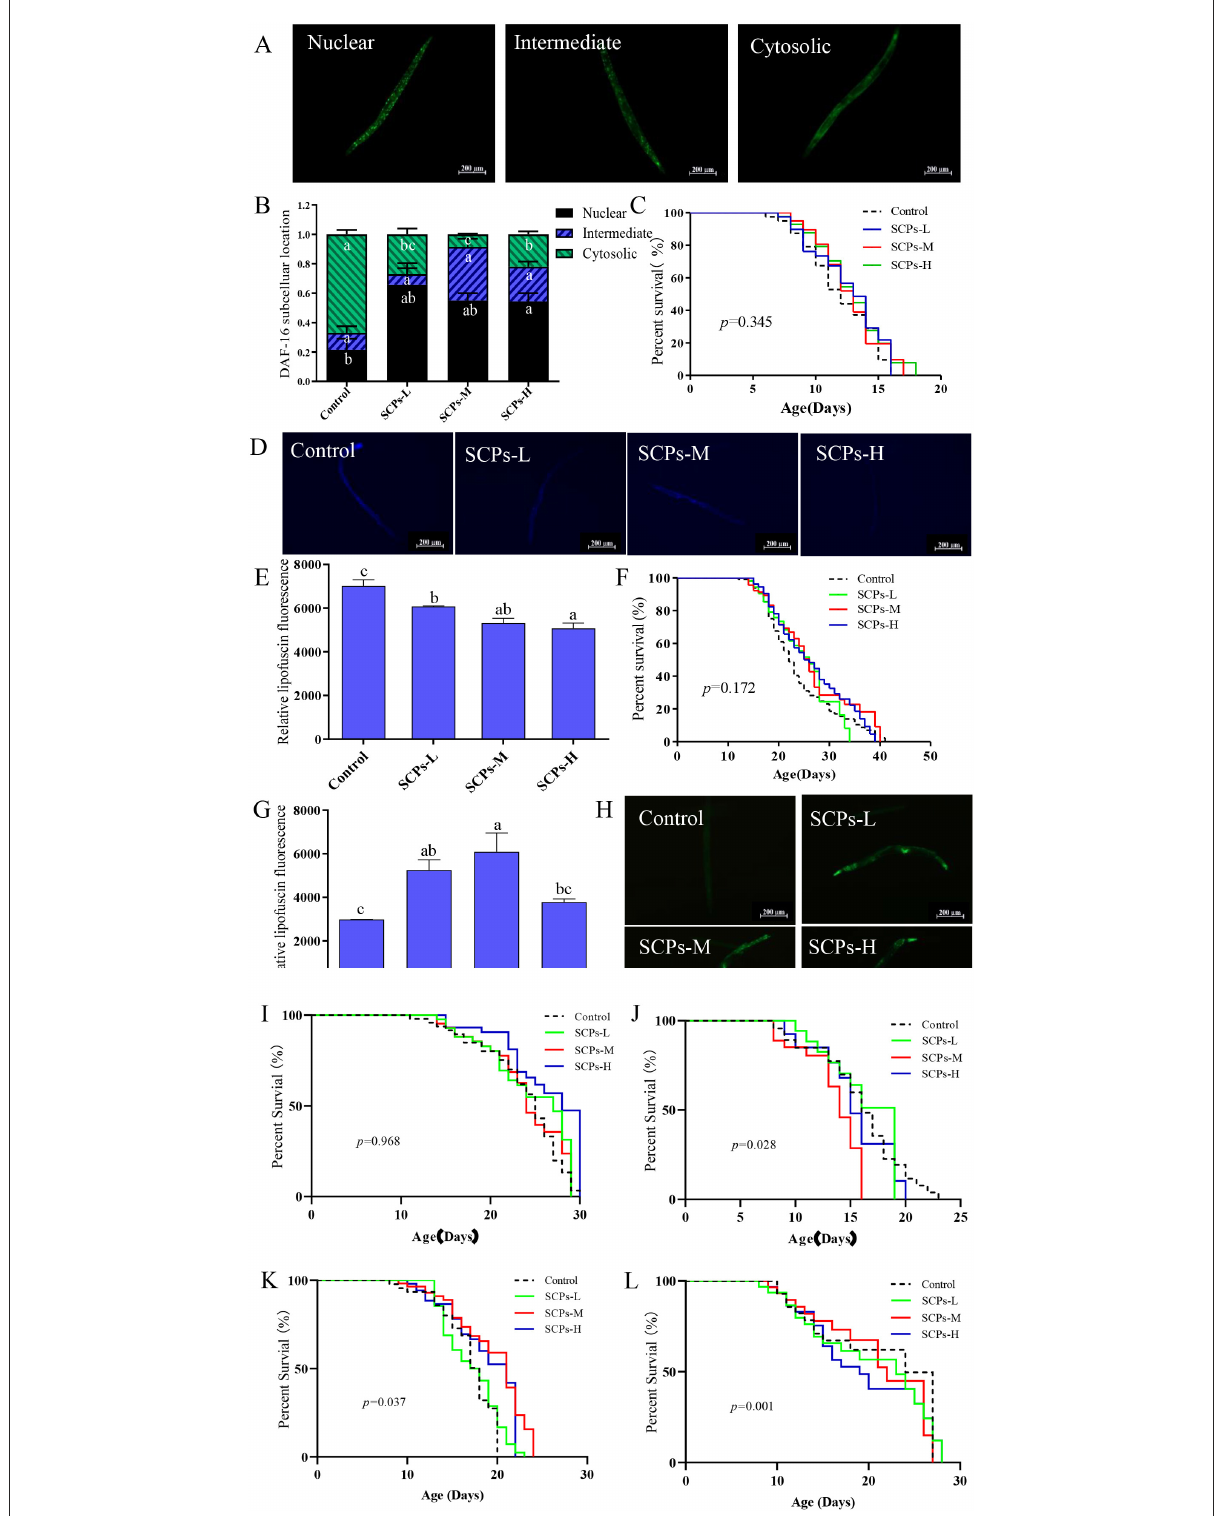
FIGURE6 SCPs extended the lifespan of C. elegans through the daf-2,daf-16 , sod-3 , old-1 , pept-1 . SCPs extended the lifespan of C. elegans and could not through the tyr-3 and acox-1.5 . (A) Distribution of DAF-16 “cytosolic,” “intermediate” and “nuclear,” (B) The proportion of DAF-16: